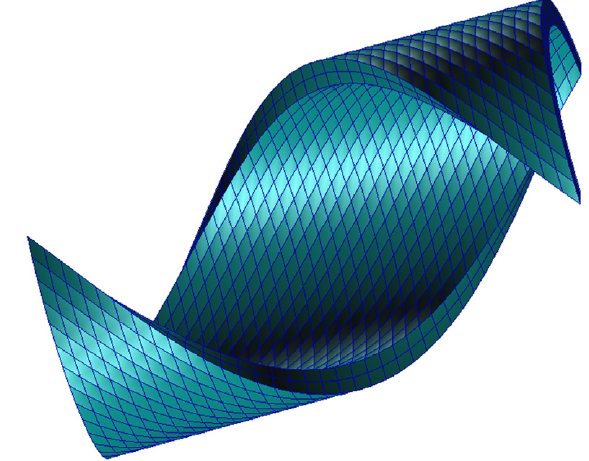
Figure 6. Spiral elements of the spiral entity.